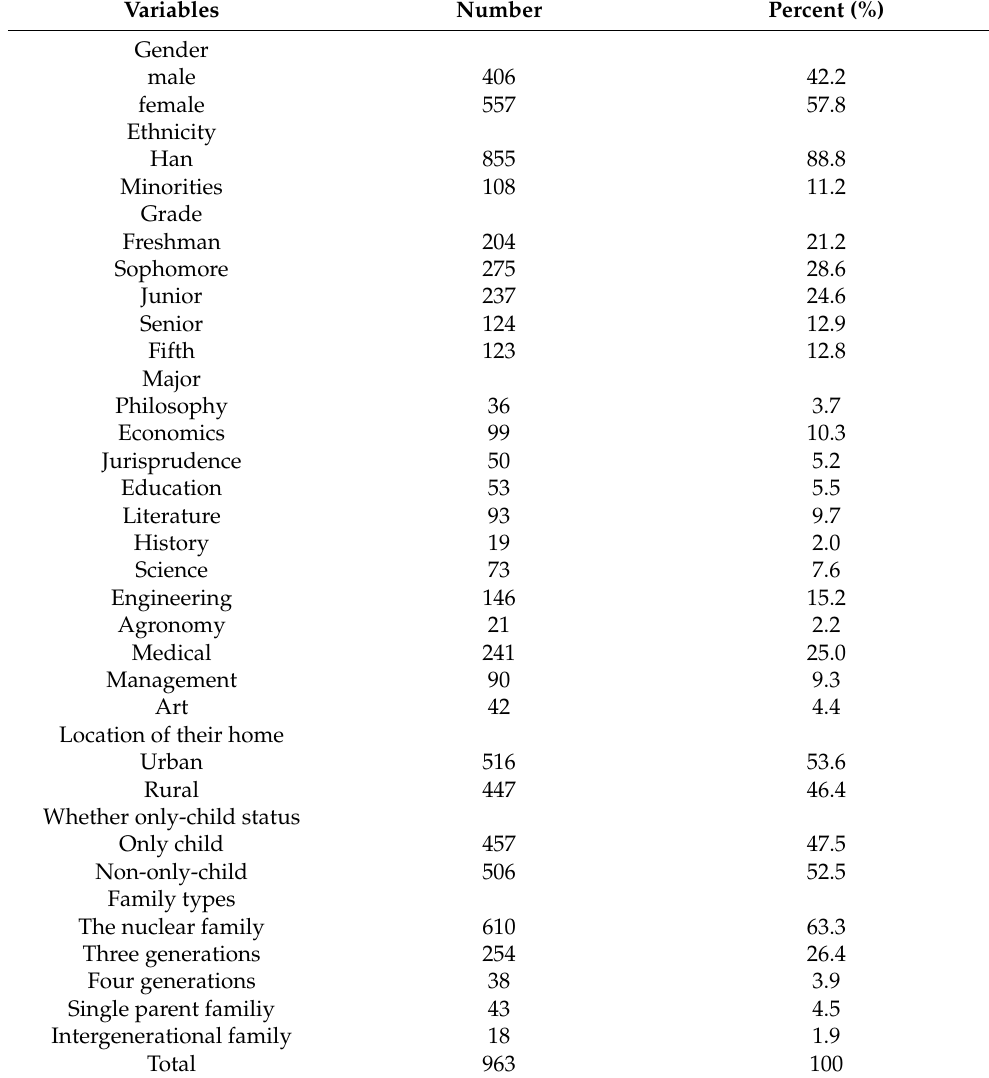
Table 1. Summary of the demographic variables (N =